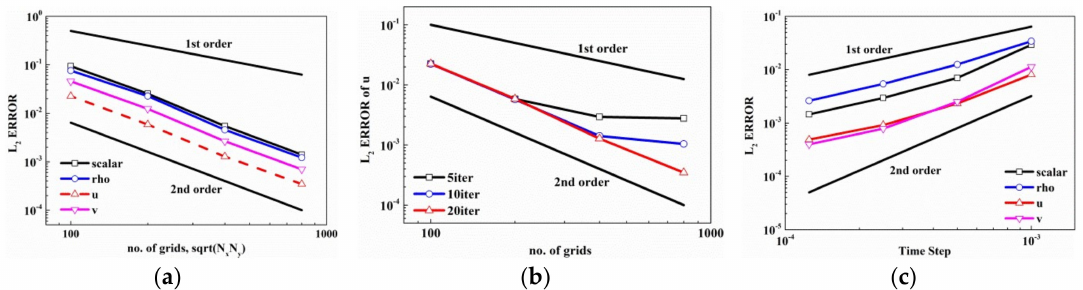
Figure 3. 2-D manufactured solutions: L 2 error: ( a ) L 2 error at t = 1 with grid refinement; ( b ) L 2 error of u at t = 1 for different numbers of sub-iteration; and ( c ) L 2 error at t = 0.1 using 1 sub-iteration on 800 × 200 grids ( u —velocity in x direction; v —velocity in y